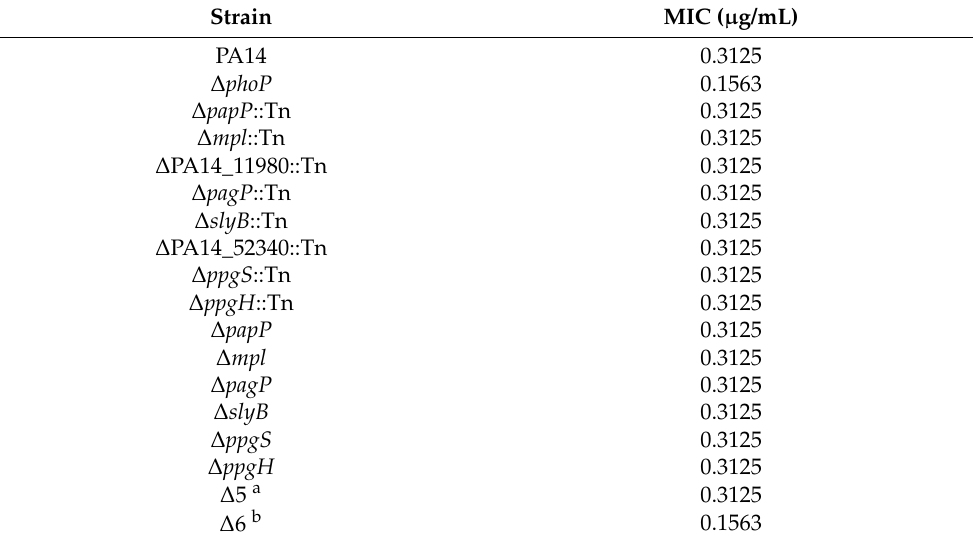
Table 3. Bacterial susceptibilities to polymyxin